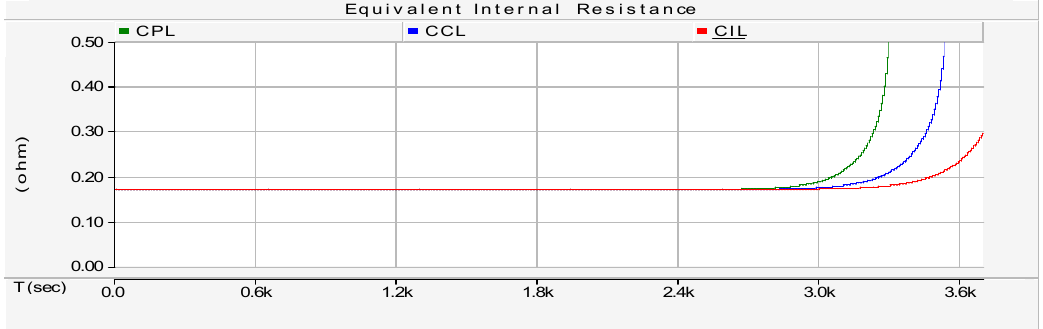
Figure 14. Instantaneous I 2 R l oss curves.